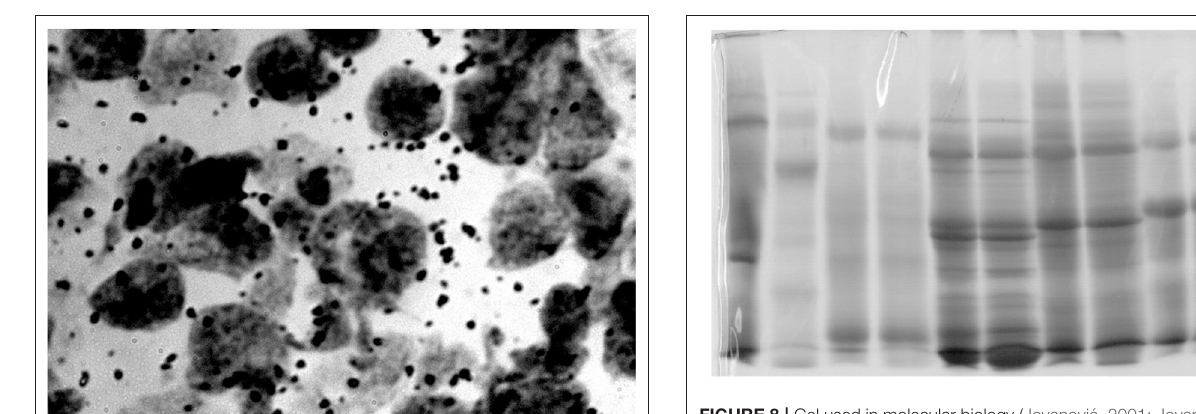
FIGURE 8 | Gel used in molecular biology (Jovanovi´c, 2001; Jovanovi´c et al.,